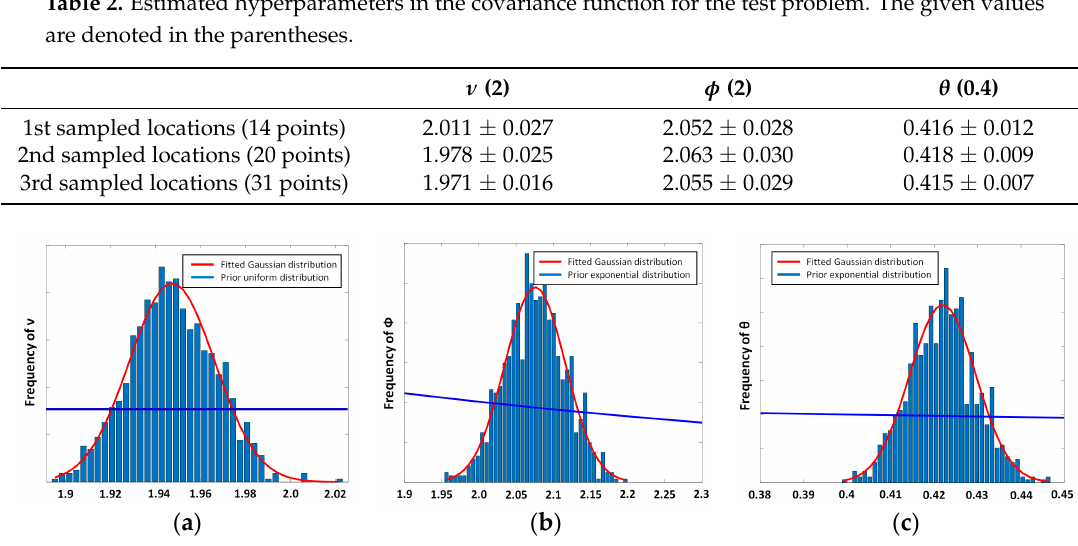
Table 2. Estimated hyperparameters in the covariance function for the test problem. The given values are denoted in the parentheses.